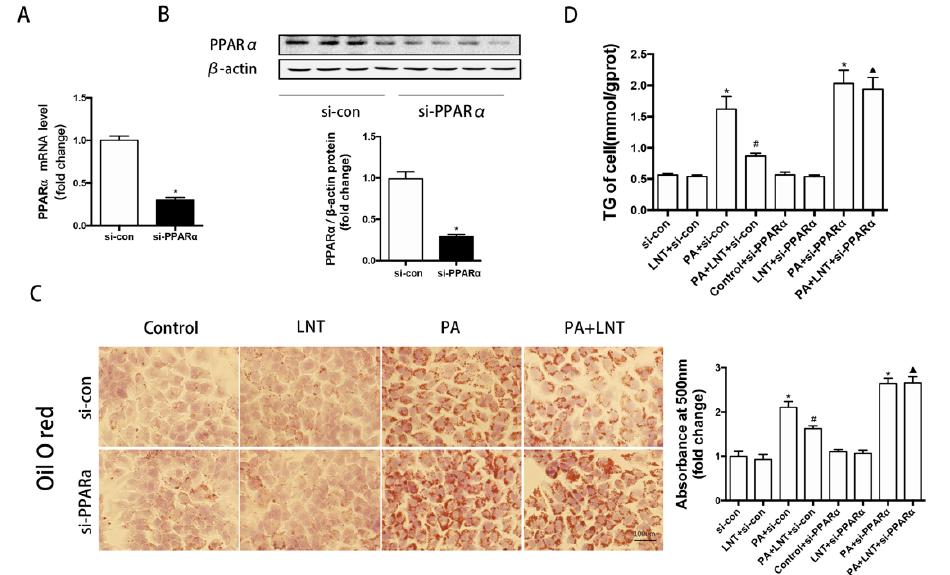
Figure 5. PPAR α knockdown abolished the protective effects of LNT on lipid deposition in PA- induced AML12 cells. ( A , B ) PPAR α mRNA and protein expression levels in AML-12 cells. ( C , D ) Oil red O staining and TG content in AML-12 cells. Data are presented as the mean ± SEM ( n = 3 per group). * p < 0.05 compared with the si-con group. # p < 0.05 compared with the PA+si-con group. ▲ p < 0.05 compared with the PA+LNT + si-con group.